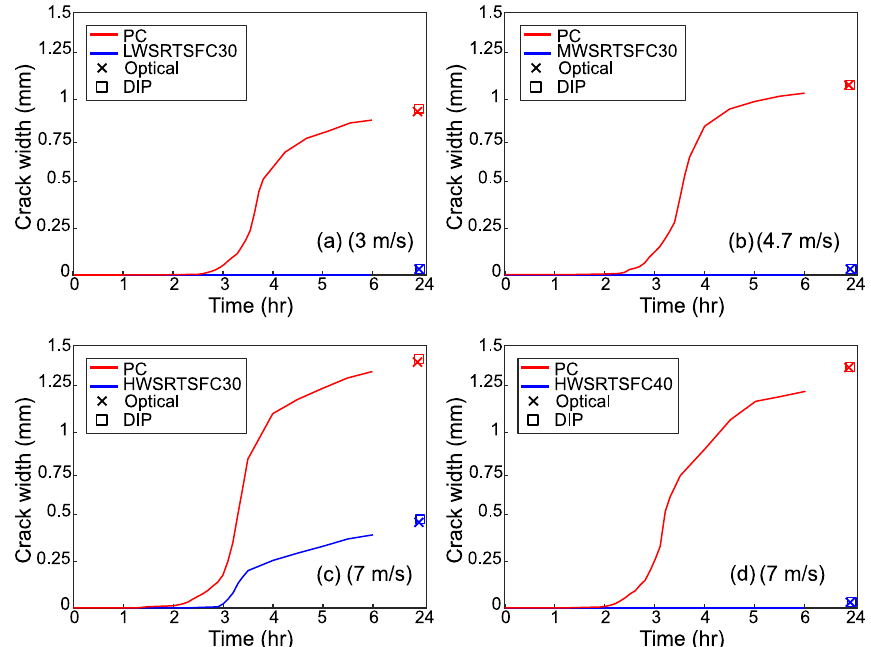
Figure 13. Crack evolution for the specimens subjected to the examined wind